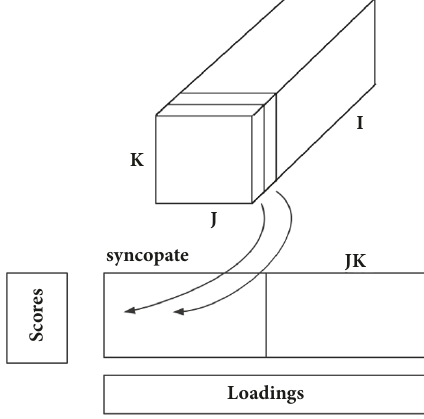
Figure 1: Computation procedure of MPCA